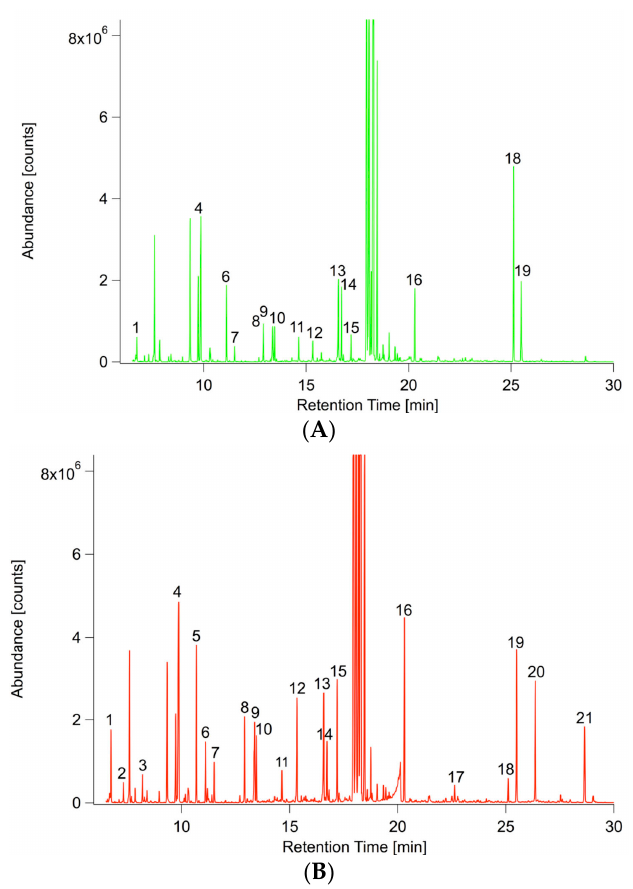
Figure 5. Representative extracted ion chromatograms ( m/z 73) of inoculated and non-inoculated A. thaliana root extracts. ( A ) Non-inoculated root; ( B ) with P. indica inoculated root. 1 : Lactic acid